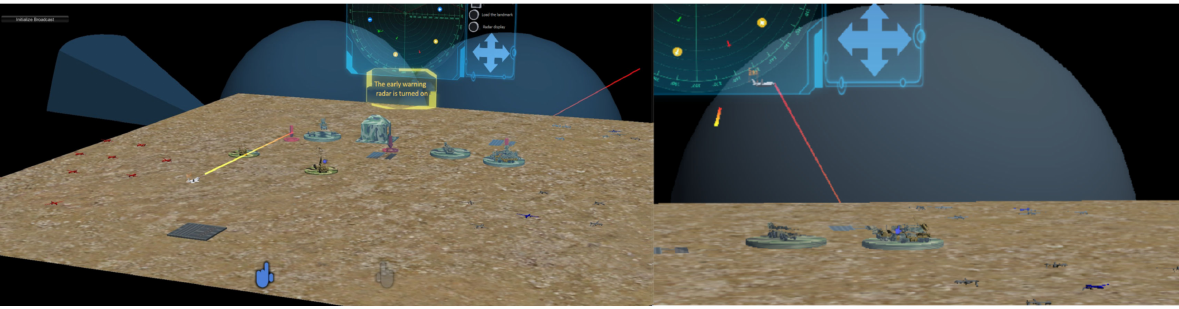
Figure 6. Radar situation.